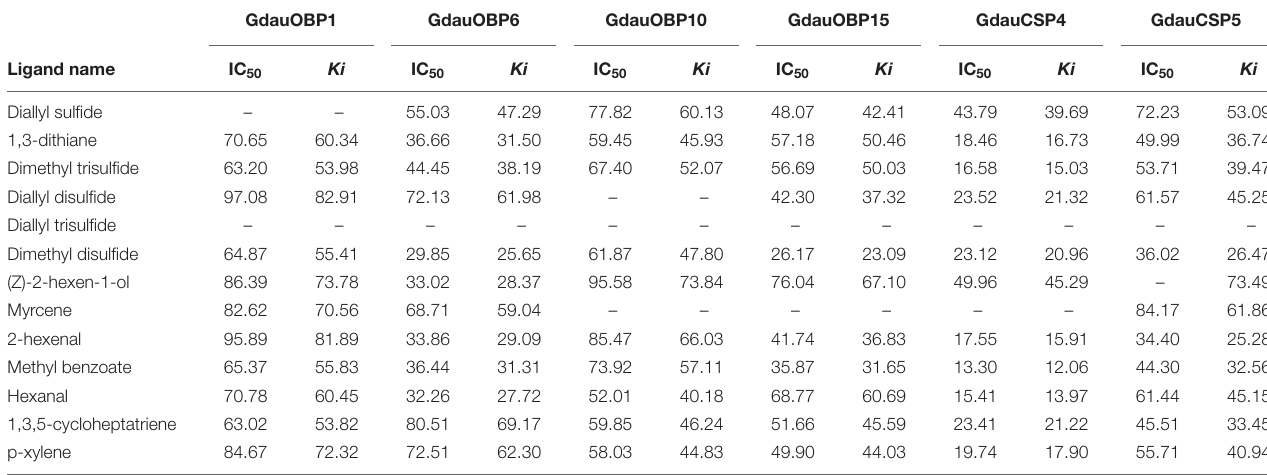
TABLE 2 | Fluorescence competitive binding affinities of four recombinant GdauOBPs and two GdauCSP proteins with different